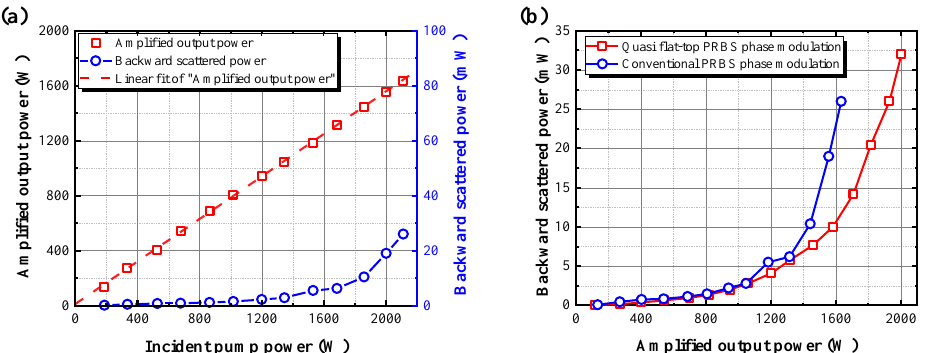
Figure 6. ( a ) The measured output power and backward scattered power as a function of the incident pump power based on the typically phase-modulated seed source; ( b ) The measured backward scattered power with different phase modulation conditions.